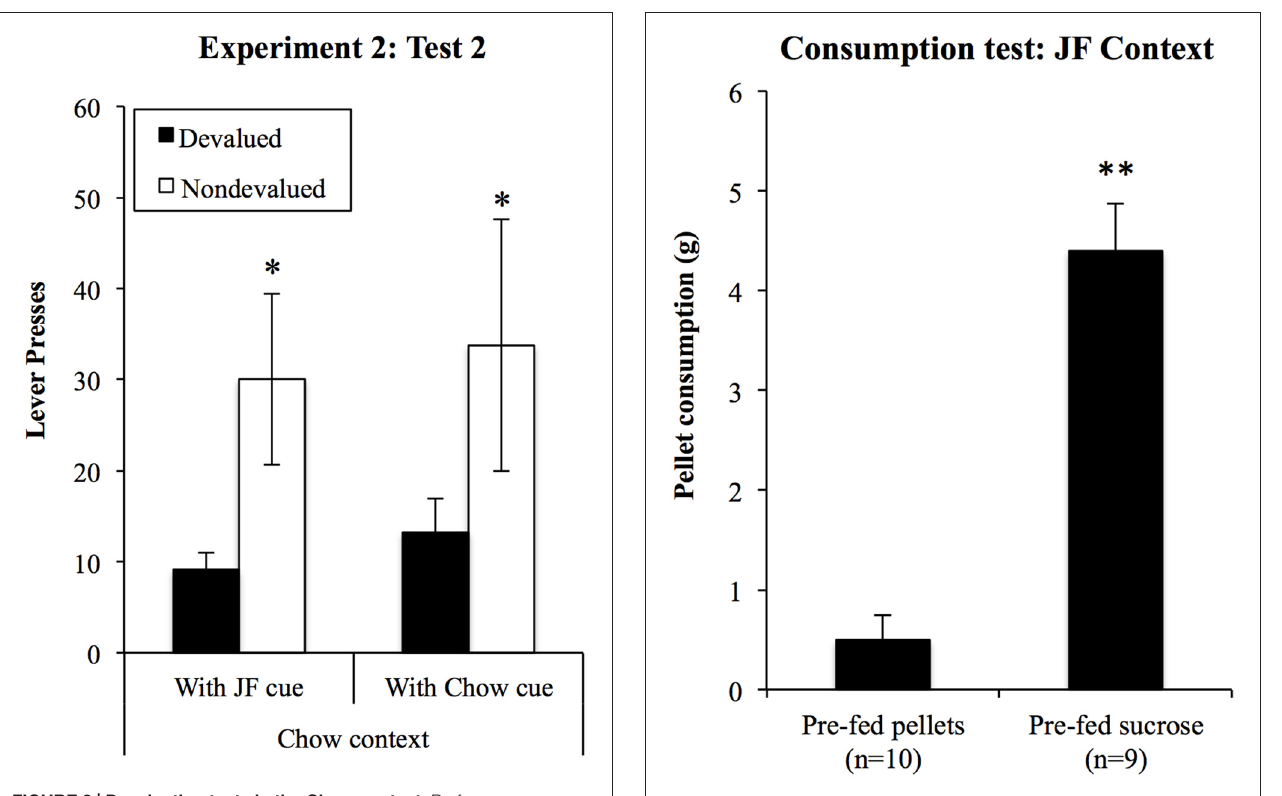
FIGURE 9 | Sensitivity to outcome devaluation measured by consumption. To test whether sensory specific satiety was intact in the JF context, pellet consumption in this context was compared between rats pre-fed with pellets and sucrose solution. Those pre-fed with pellets ate significantly less than those pre-fed with sucrose solution, ∗∗ indicates p <